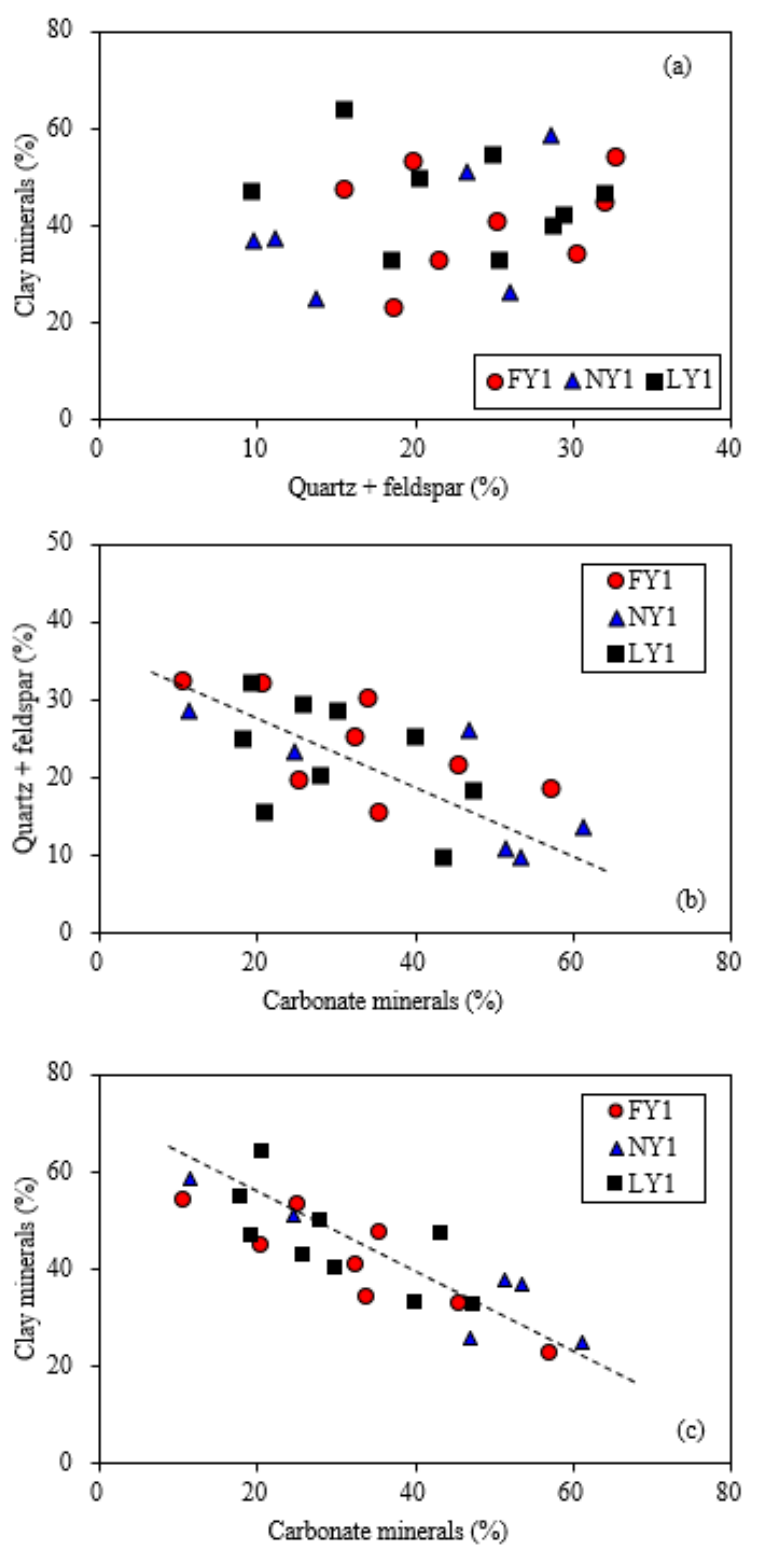
Figure 7. Plots showing relationships between different minerals for the studied samples. Clay minerals showed no correlations with quartz + feldspar ( a ). Carbonate minerals showed negative correlations with quartz + feldspar ( b ) and clay minerals ( c ).